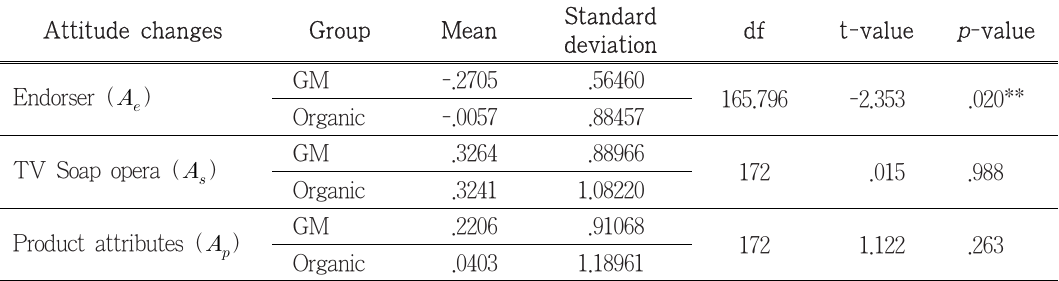
<Table 1> Results of independent Sample